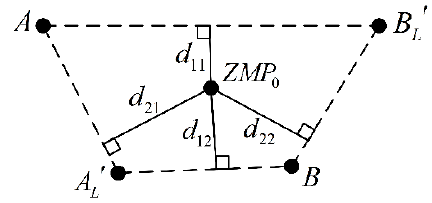
Figure 8. Distances between ZMP 0 and each boundary of the virtual-support quadrilateral.